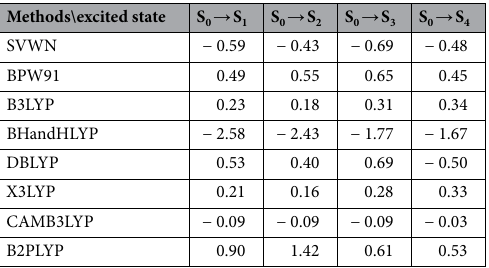
Table 1. Errors for the transition energies of the first four excited states between CCSD and the eight different DFT methods for Zn